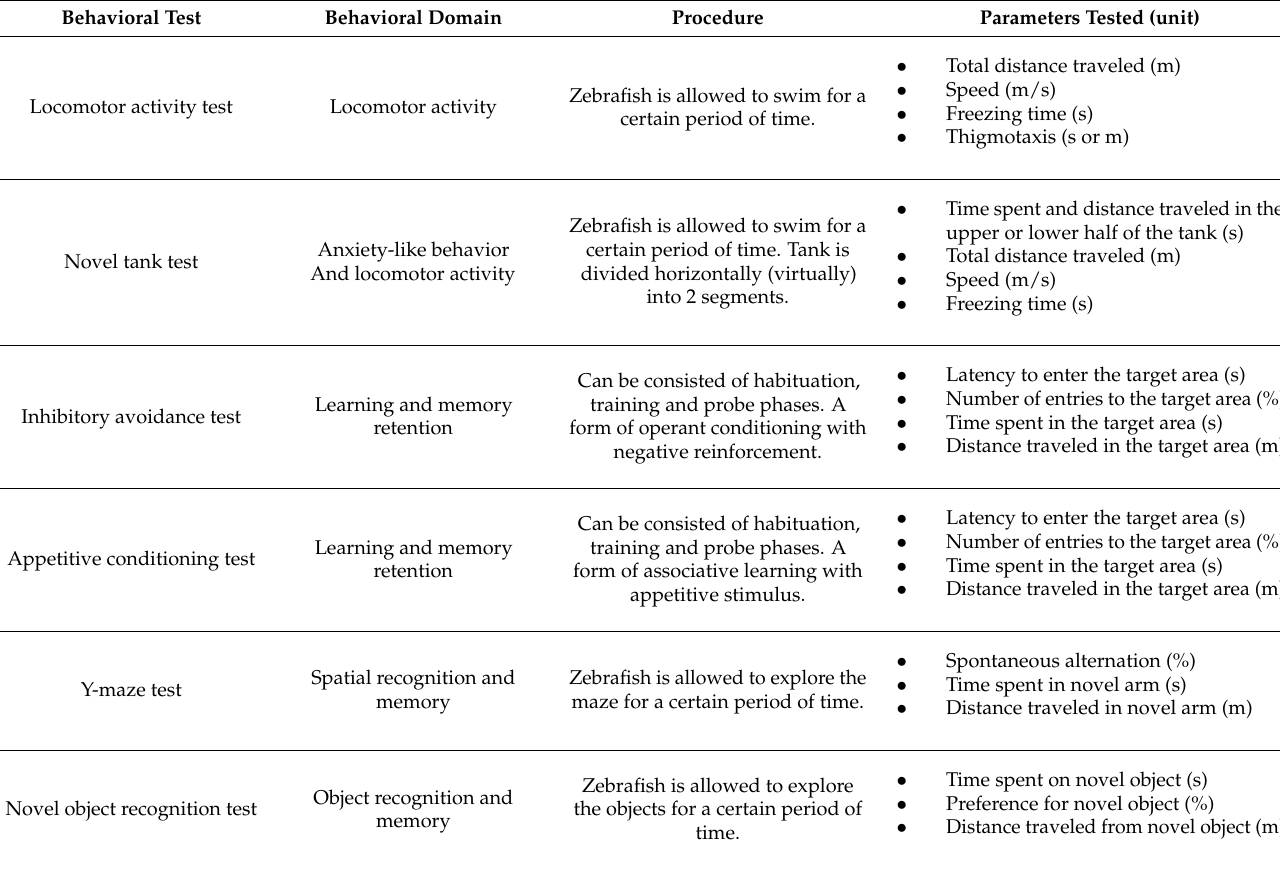
Table 2. Neurobehavioral assessment tests in